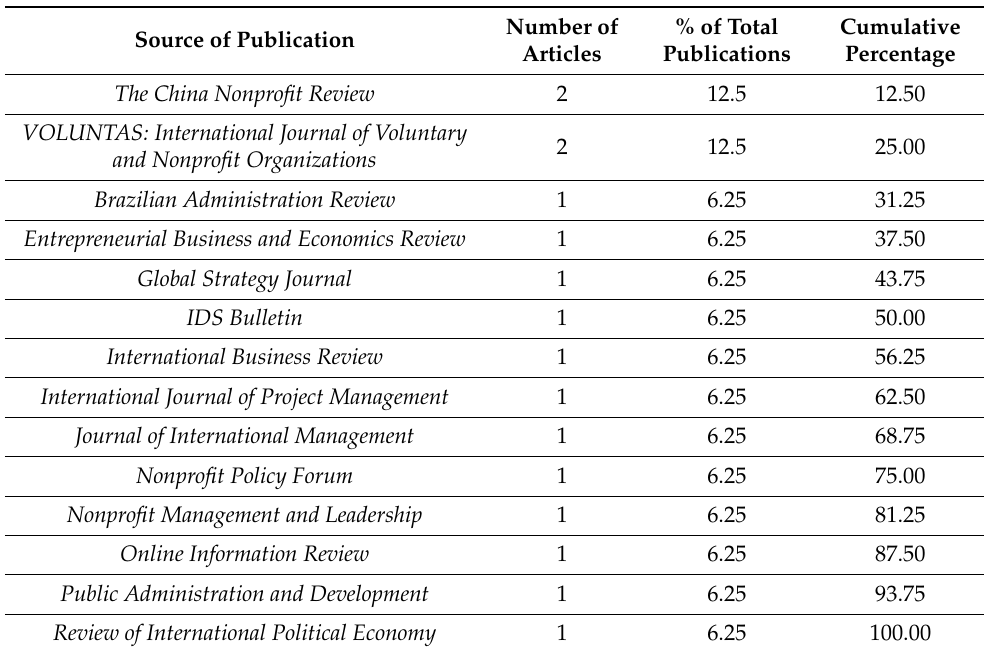
Table 5. Main outlets of